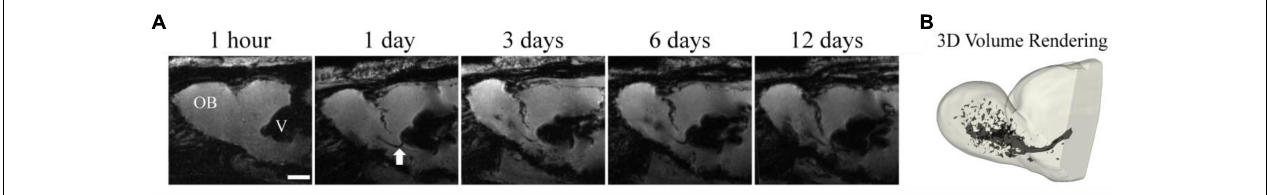
FIGURE 2 | Temporal resolution during early migratory events. MPIOs (50 µ L) were injected into the anterior horn of the lateral ventricle proximal to the SVZ in healthy adult rats. 3D gradient echo images of a rat brain were serially acquired at 1 h, 1 days, 3 days, 6 days, and 12 days (A) post injection. The RMS is visible on the day 1 images as a dark line extending from the ventricle (white arrow). Migration across the entire OB is visible by day 12, the 3D volume rendering of the OB (B) shows the extent of cells within the structure (Adapted from Shuboni-Mulligan et al., 2018).